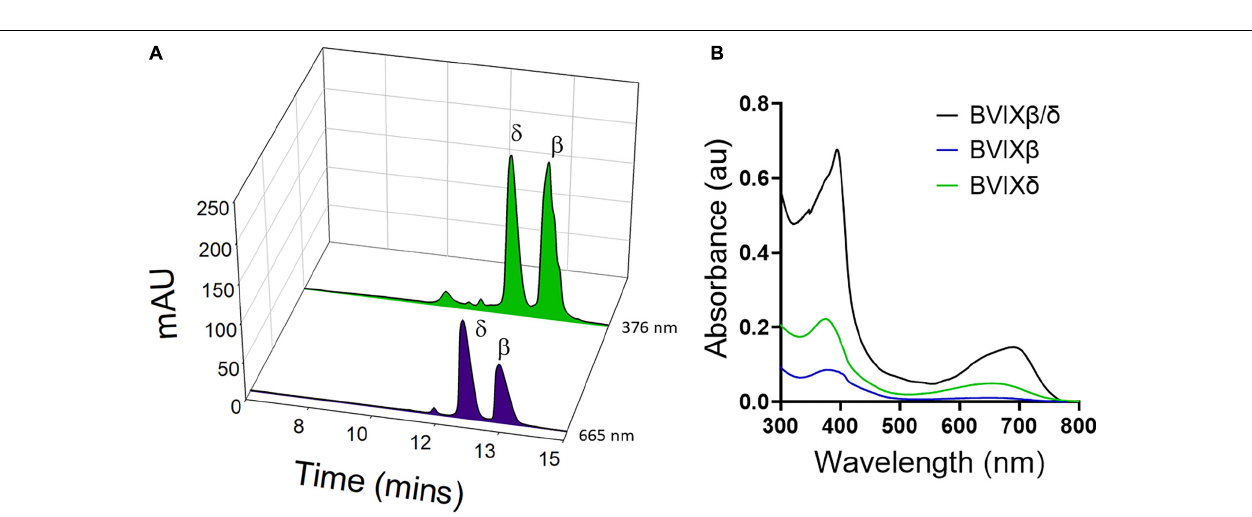
FIGURE 2 | Induction temperature optimization of HemO over-expression in EcN(T7) cells. (A) Cultures, supernatants, and pellets after 16 h of induction at different temperatures (17, 25, 30, and 37) shaking at 250 rpm, supplemented with 10 µ M heme, and induced with 1 mM IPTG. (B) Acidified supernatant. (C) Acidified and filtered supernatant applied onto a C18 Sep-Pak column (35cc, Waters) showing a green band of BVIX δ and BVIX β isomers.